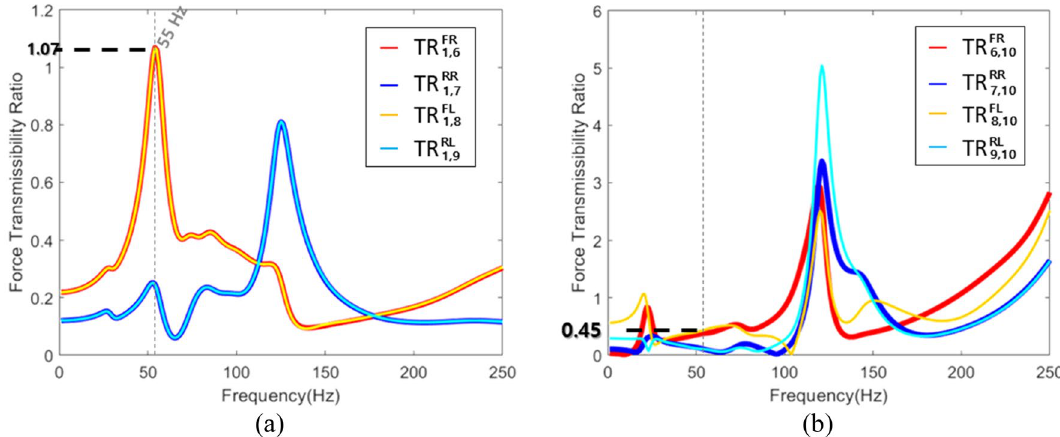
Figure 7. The force transmissibility ratio of the connection part and response point. ( a ) Connection part (using contact force); ( b ) Response point (using transmitted